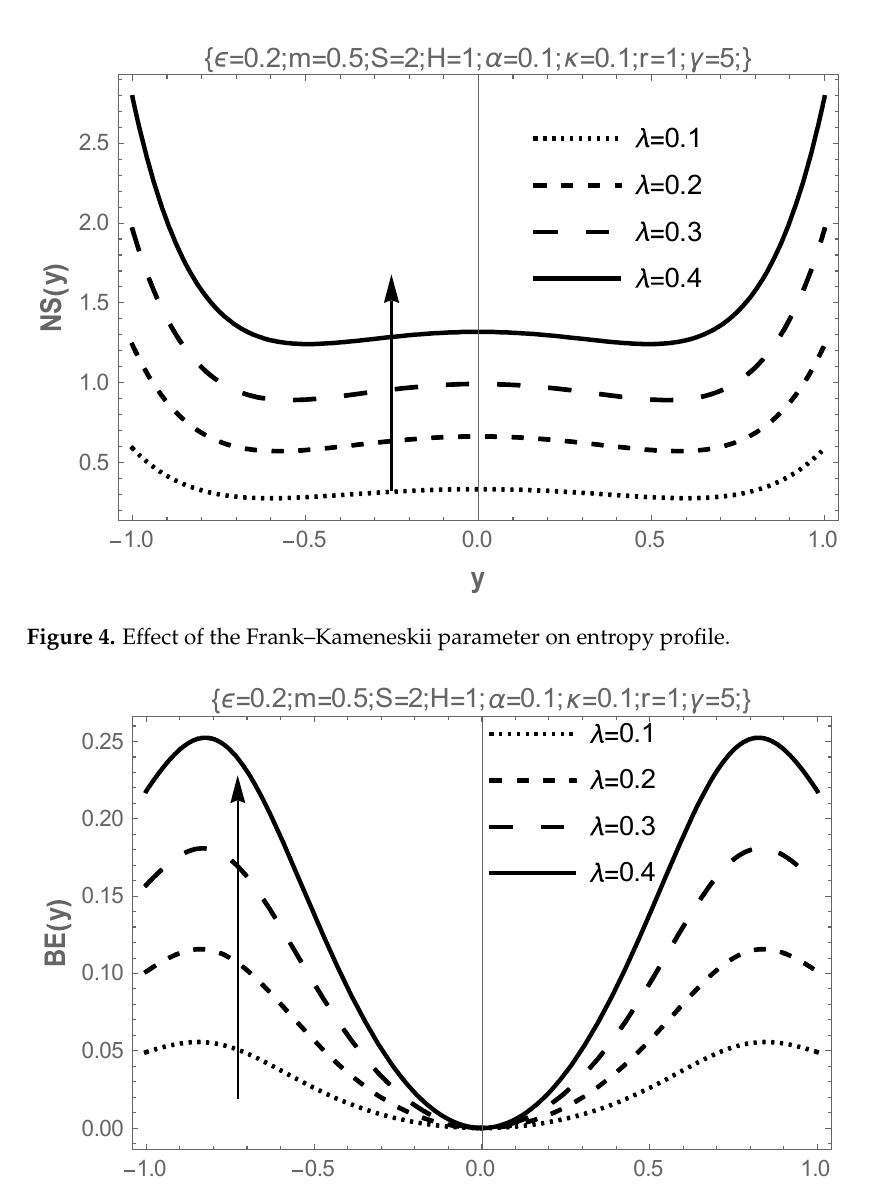
Figure 5. Effect of the Frank–Kameneskii parameter on Bejan profile. Figure 6 represents the effect of the porous permeability variation parameter on flow velocity. The plot reveals that the flow velocity maximum rises with increasing values of the passable permeability parameter. This is because as temperature increases, there is a reduction in the viscosity of the third-grade fluid. This encourages flow due to the increased permeability of the porous matrix. The increase in porous permeability with the temperature of the fluid is presented in Figure 7. The result shows that the fluid’s porous permeability improves temperature distribution within the flow channel. This is connected with the reduced activation energy of the combustible liquid. Figure 8 shows the effect of variations in porous permeability on the entropy generation rate. The fact that flow velocity and temperature distribution increases with this parameter indicates that frictional interaction within the fluid layer is negligible. Therefore, the entropy profile is on the rise across the channel. Finally, fluid viscosity-related irreversibility dominates significantly over heat-transfer irreversibility at the core center of the flow channel. In contrast, heat transfer irreversibility is more prominent at the walls, as seen in Figure